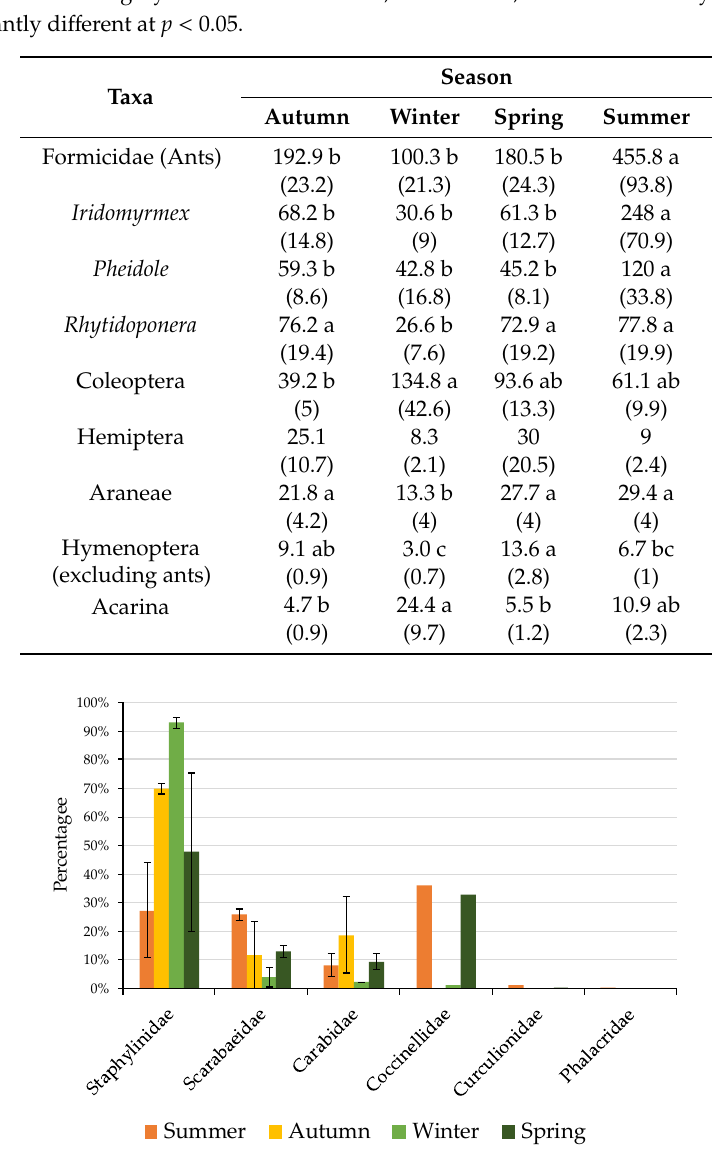
Figure 4. Proportion of Coleoptera Families (mean total per field) recorded seasonally and averaged over all land use types, and agricultural management regimes during the study period. Each data point was the total abundance of 20 pitfall traps per field, with each field (n = 24) sampled on eight occasions, once in each season and repeated in the following calendar year.